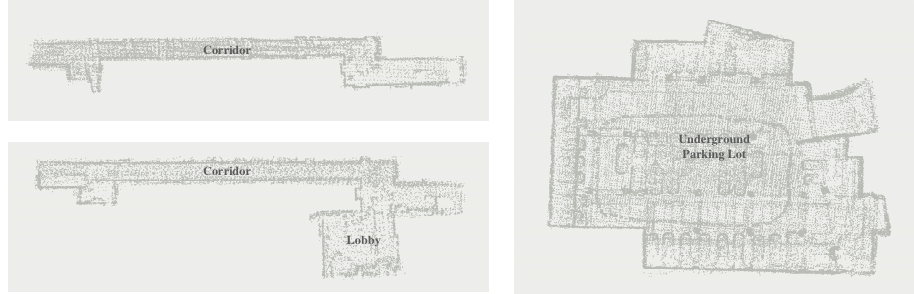
Figure 8. Point cloud map of the scenes. The ceiling dataset contains scene 1 of Floor 3 (top left), scene 2 of Floor 1 (bottom left), and scene 3 of the underground parking lot (right).